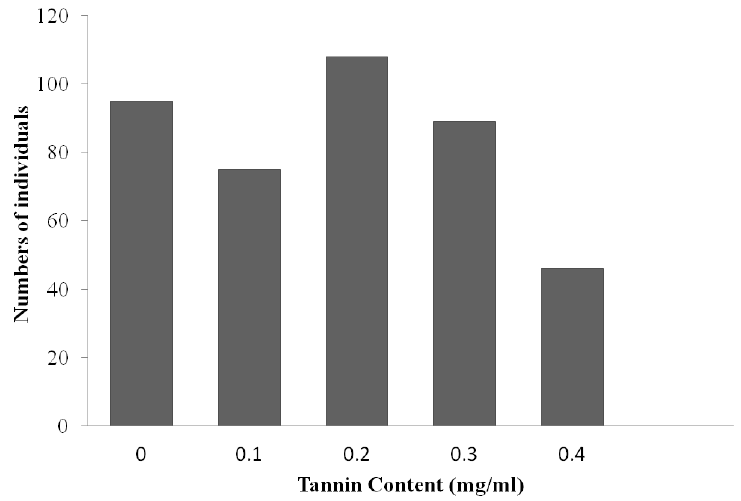
Figure 1. Frequency distributions of tannin content in 413 plants of F 2 population.